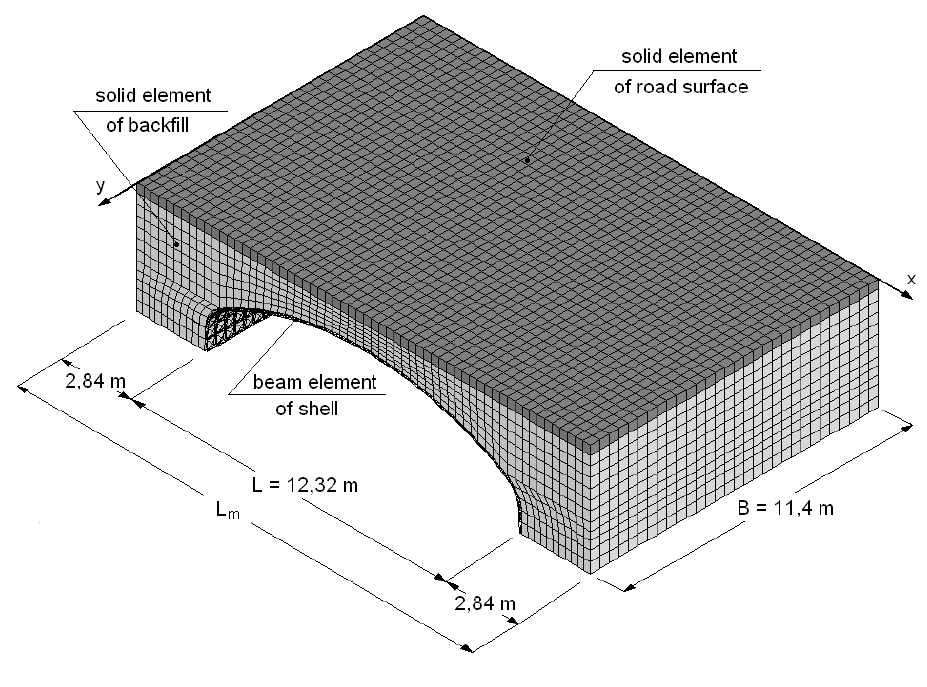
Figure 1: 3D model of a soil-shell object [14,